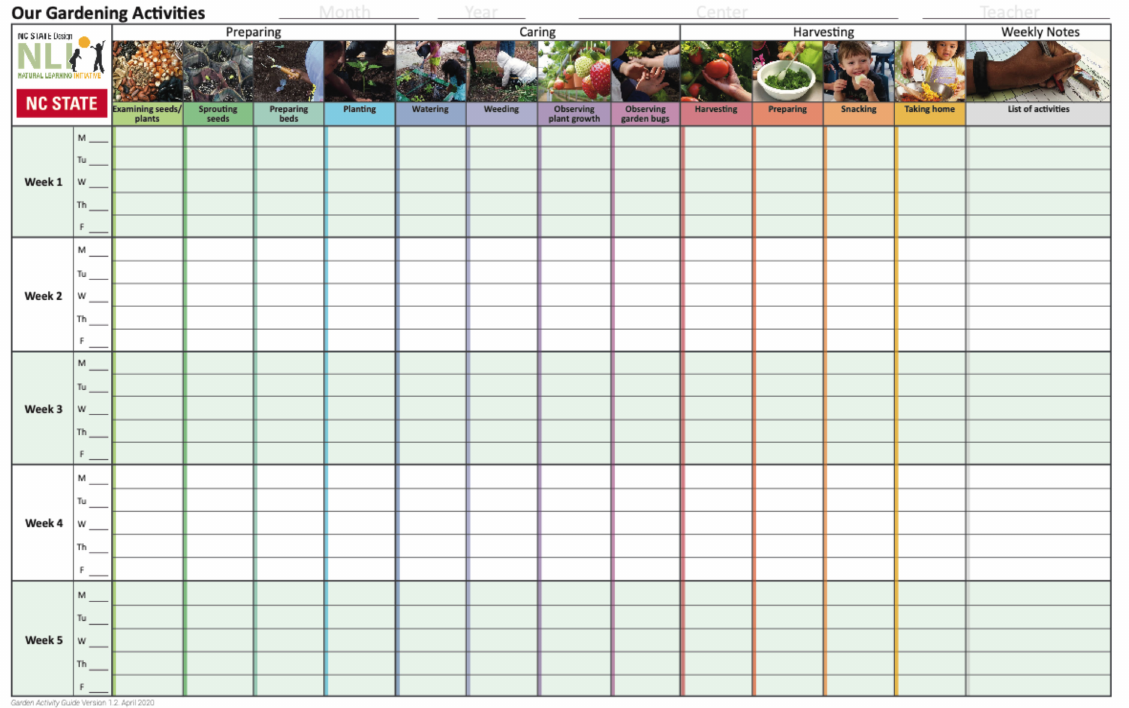
Figure 6. GaFT laminated wall chart to record gardening